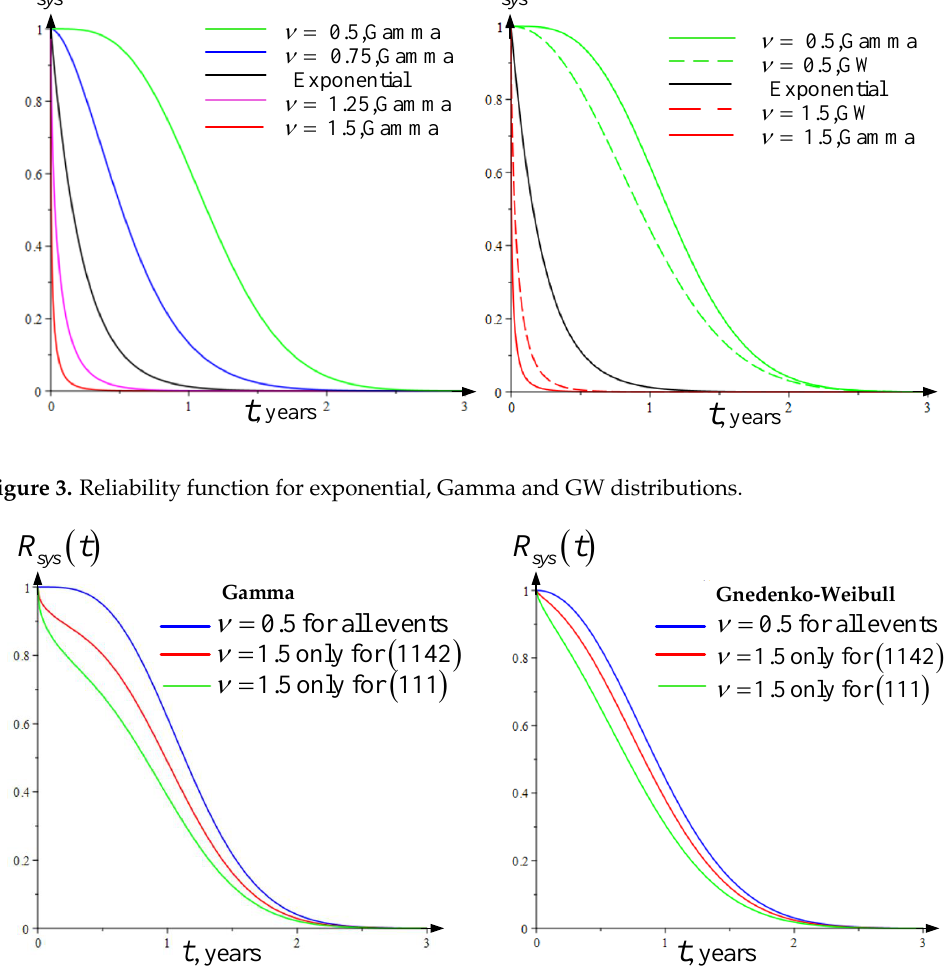
Figure 4. Reliability function with the effect of changing v for a single